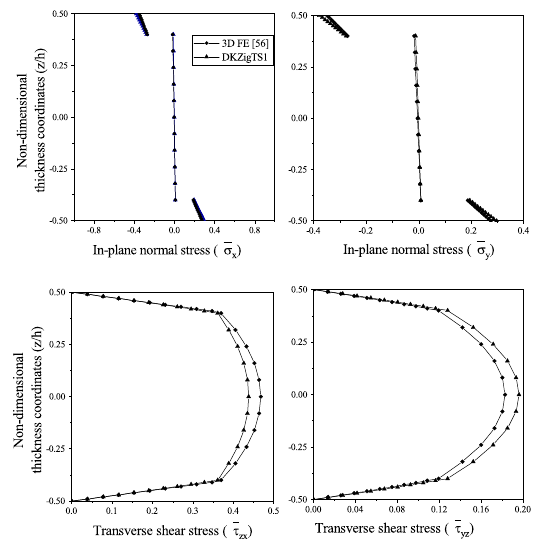
Figure 13: Through the thickness variation of in-plane normal and transverse shear stress for panel ’G’